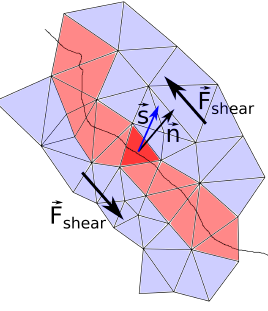
Figure 9. Crack width, the constant edge (cid:126)s 12 ref is shifted to edge (cid:126)s 12 Figure 10. Triangle mesh, red: extended triangles; blue: triangles without strains; shear forces affect along crack direction in opposite direction; the principal strain vector (cid:126)s is not parallel to the crack normal (cid:126)n